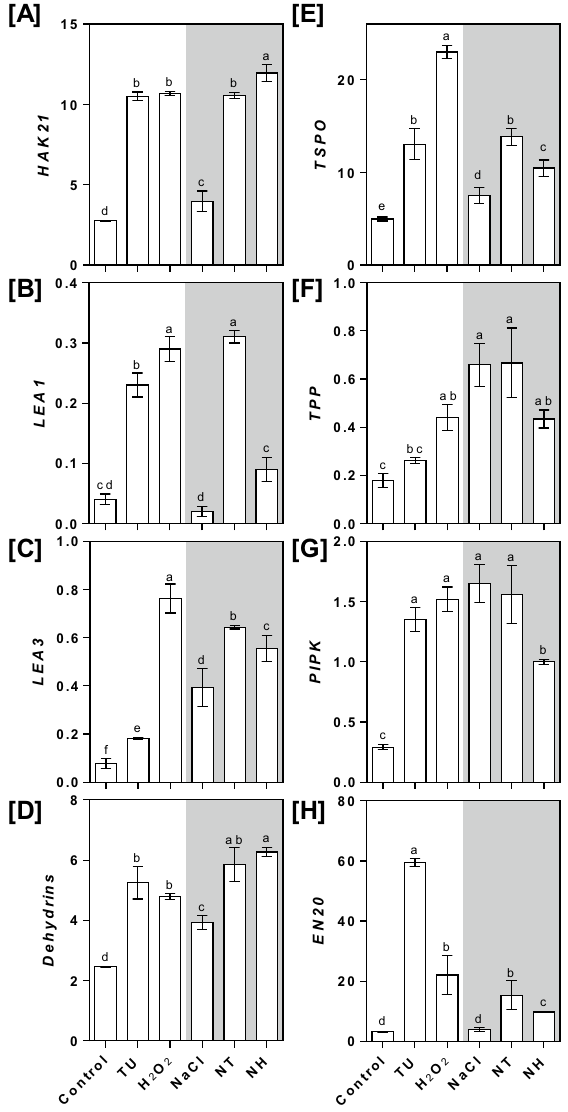
Figure 3. Real-time PCR based quantification of NaCl stress responsive genes in rice seedlings under different treatments. The rice seedlings were grown hydroponically for 14 days under control conditions and then, subjected to different treatments including control (Yoshida medium), NaCl (50 mM), TU (7.5 µM), NaCl (50 mM) + TU (7.5 µM) [NT], H 2 O 2 (1 µM) and NaCl (50 mM) + H 2 O 2 (1 µM) [NH]. After 6 h of treatment, the leaf tissue was harvested and analysed for relative expression of high ‐ affinity K + transporter ( HAK21 ; A ), late embryogenic abundant protein-1 ( LEA1 ; B ), late embryogenic abundant protein-3 (LEA3; C ), dehydrin ( D ), translocator protein ( TSPO ; E ), trehalose-phosphate phosphatase ( TPP ; E ), phosphatidylinositol-4-phosphate 5 kinase ( PIPK ; F ) and early nodulin-20 ( EN20 ; H ). All the values are mean of triplicates ± SD and are normalized using tubulin as constitutive gene. Different letters indicate significantly different values (DMRT, p ≤ 0.05 )